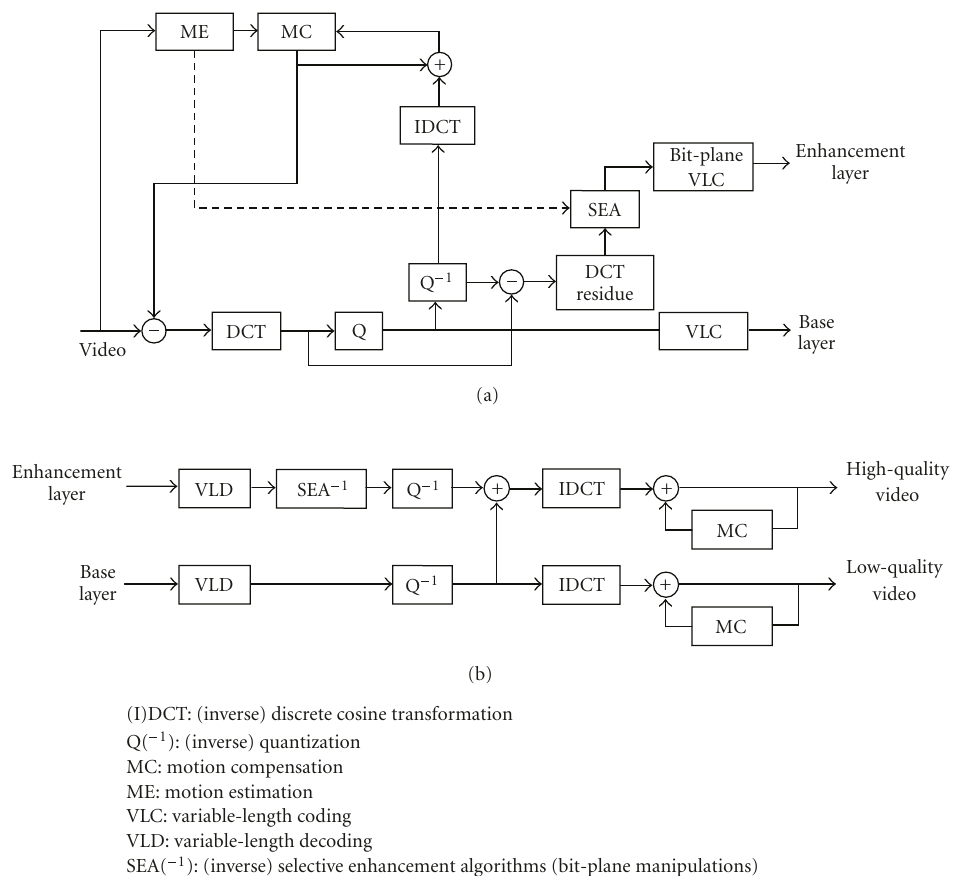
Figure 1: (a) MPEG-4 FGS encoder and (b) MPEG-4 FGS decoder with shifting